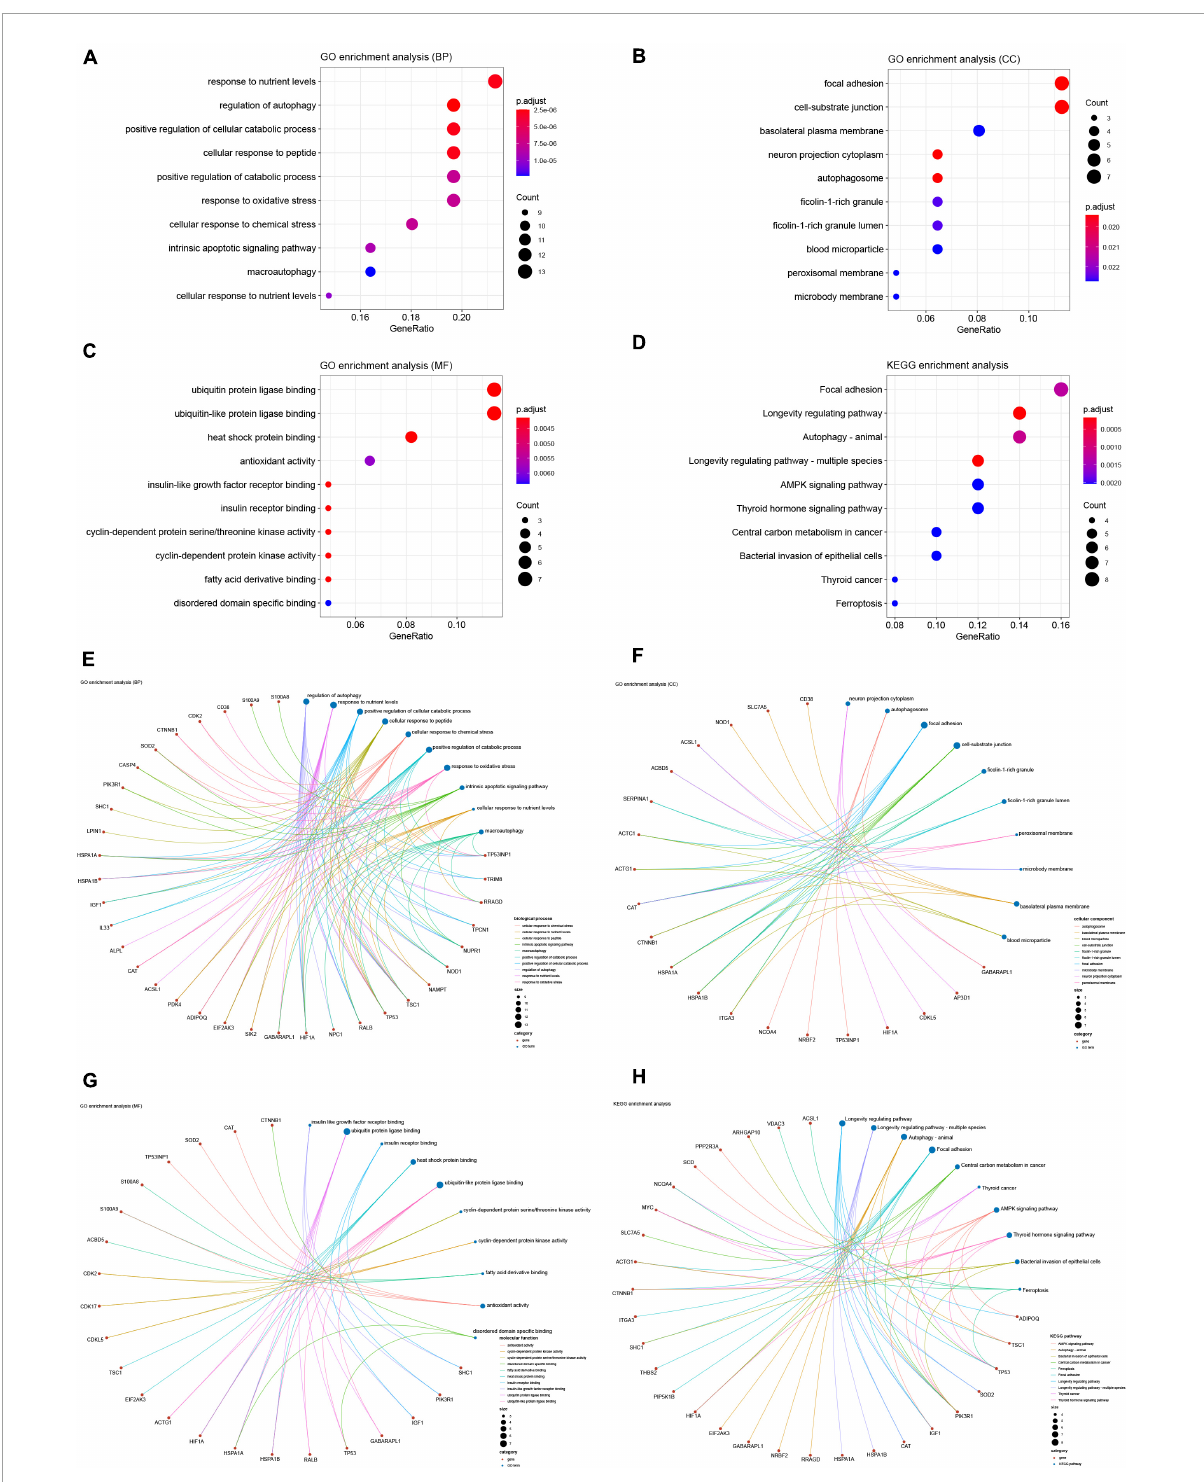
FIGURE4 Gene Ontology (GO) and Kyoto Encyclopedia of Genes and Genomes (KEGG) enrichment analyses of differentially expressed ferroptosis-related genes. GO enrichment analysis of DEARGs in (A) the biological process category (BP); (B) the cellular component category (CC); (C) the molecular function category (MF). (D) KEGG enrichment analysis of DEARGs. Crosstalk analysis between DEFRGs and (E) gene functions in BP; (F) gene functions in CC; (G) gene functions in MF; (H) KEGG pathways. DEARG, differentially expressed autophagy-related